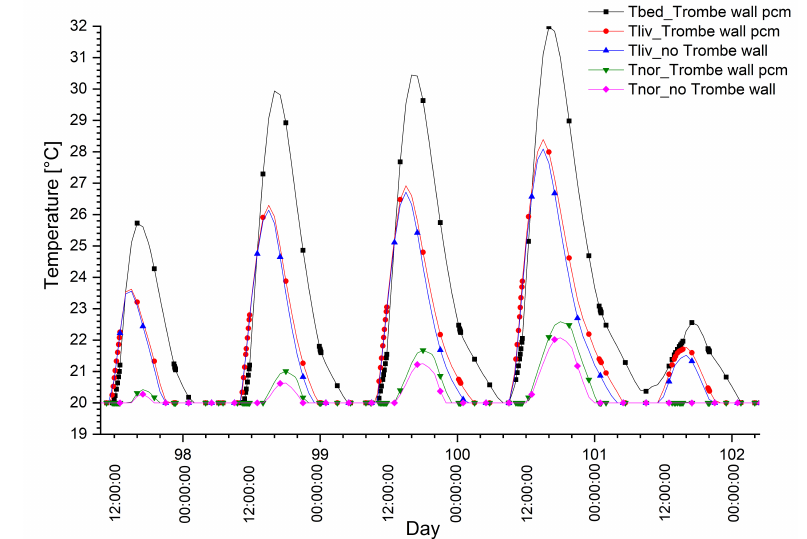
Figure 18. Comparison of temperatures in the living room and north-facing rooms for the case of the bedroom equipped both with and without the PCM solar Trombe